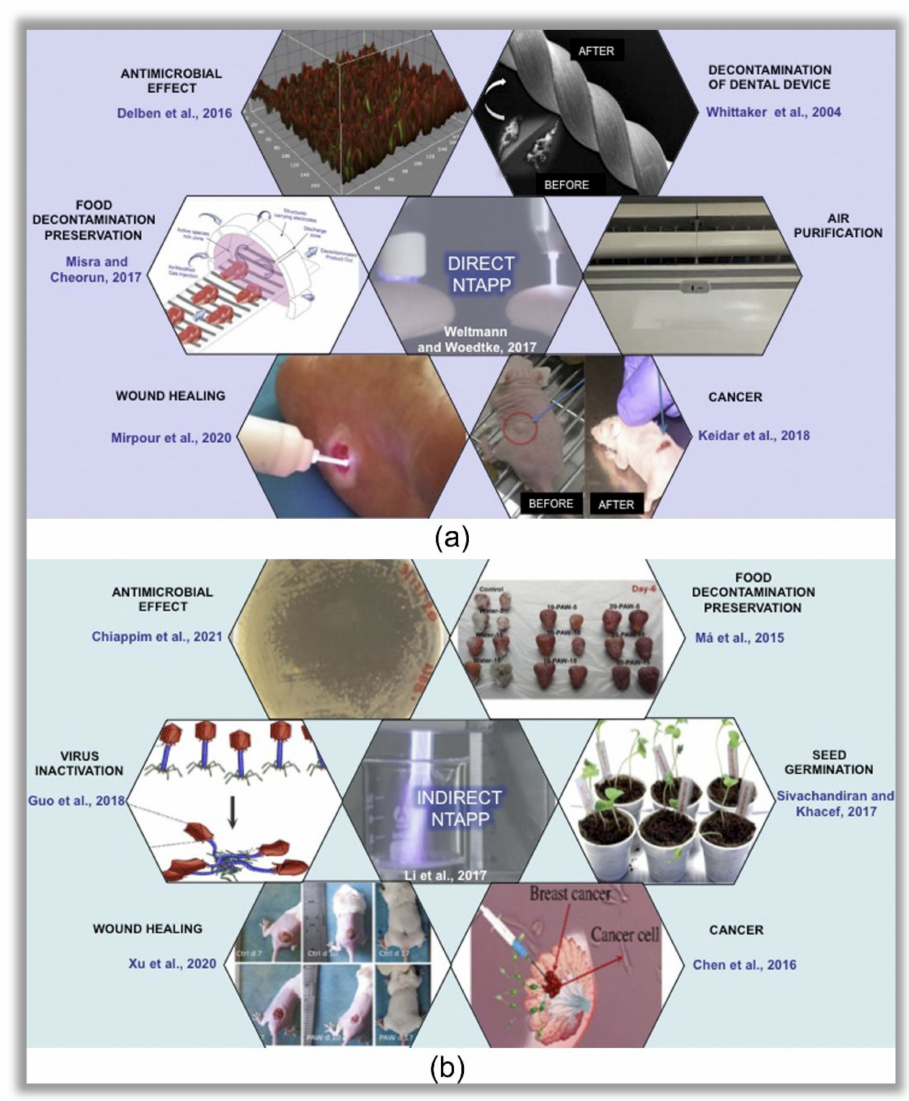
Figure 1. Schematic illustration of direct ( a ) and indirect ( b ) applications of non-thermal atmospheric pressure plasmas (NTAPPs). Note that due its antimicrobial effect, direct NTAPPs have been used